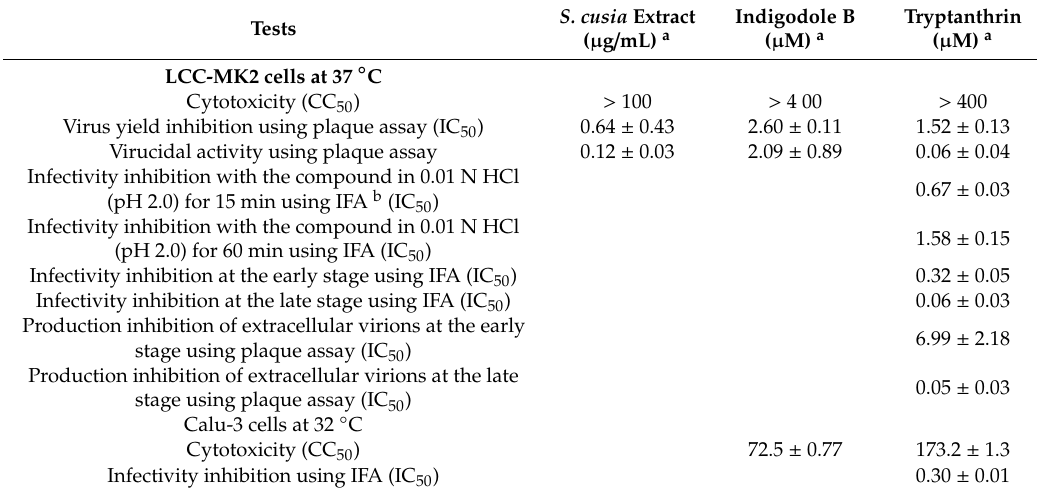
Table 1. Cytotoxicity and anti-human coronavirus NL63 (HCoV-NL63) activity of Strobilanthes cusia leaf methanol extract, indigodole B, and tryptantrin.